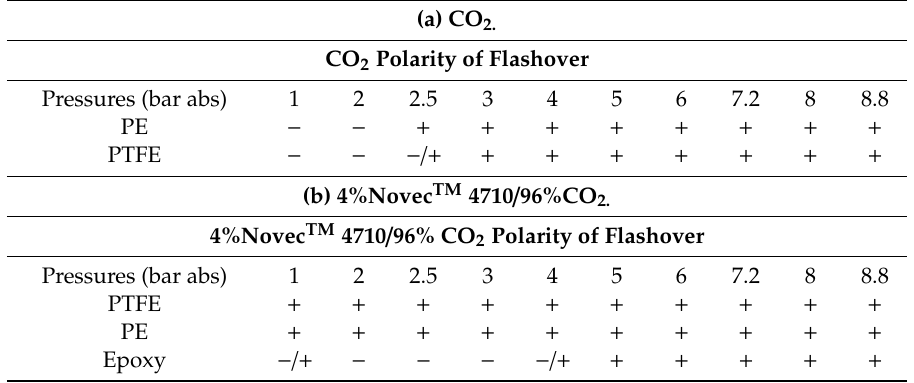
Table 3. AC Flashover polarity under di ff erent pressures up to 8.8 bar abs (Needle on HV) Electrode). (a) CO 2.